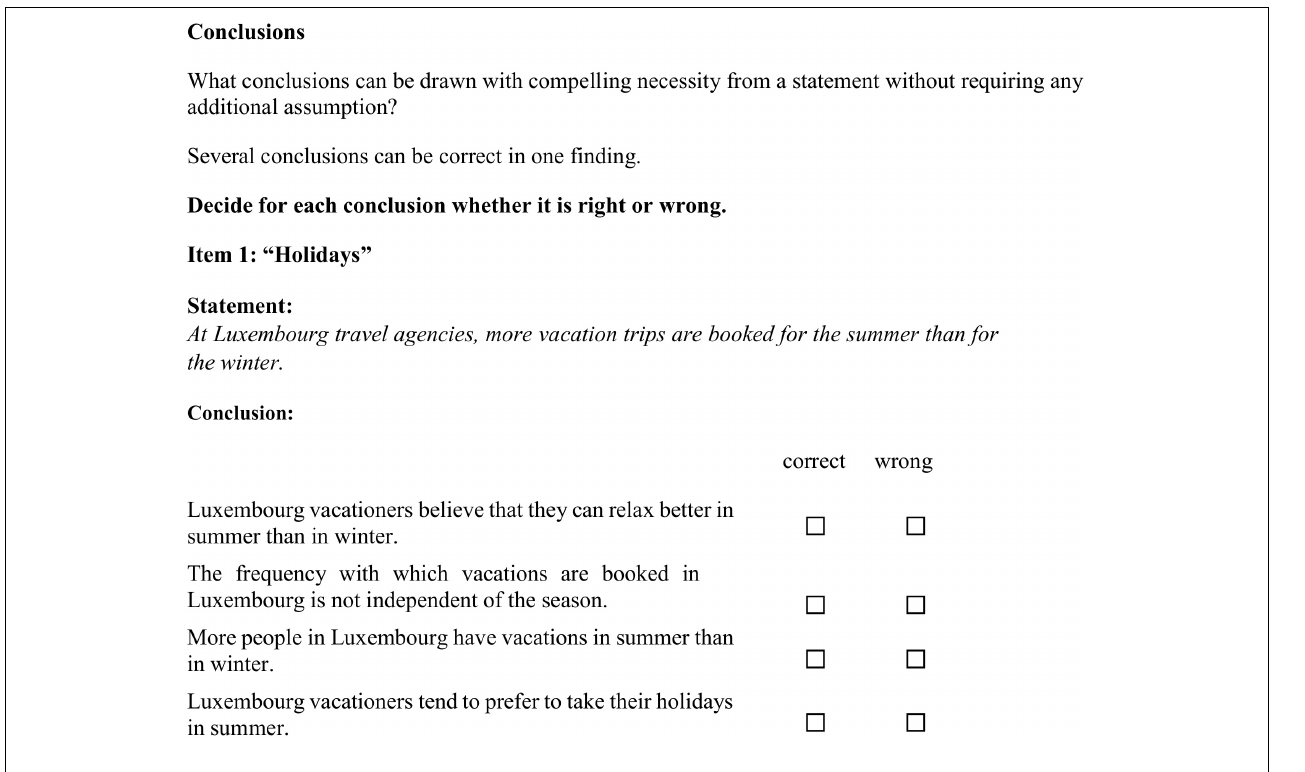
FIGURE 3 | General intelligence items on the topic “Vacations” (from parcel 1; from Jäger et al.,